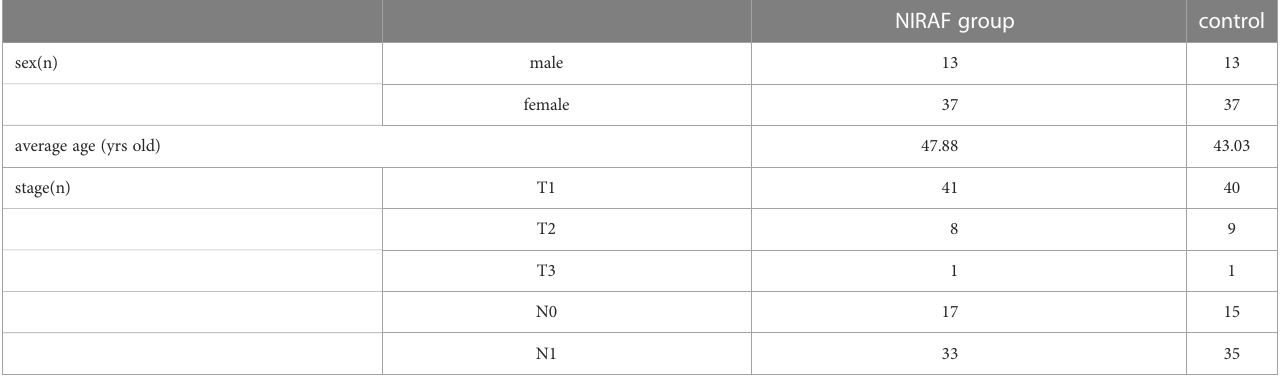
TABLE 1 Demographics for the 100 patients with papillary thyroid carcinoma in this